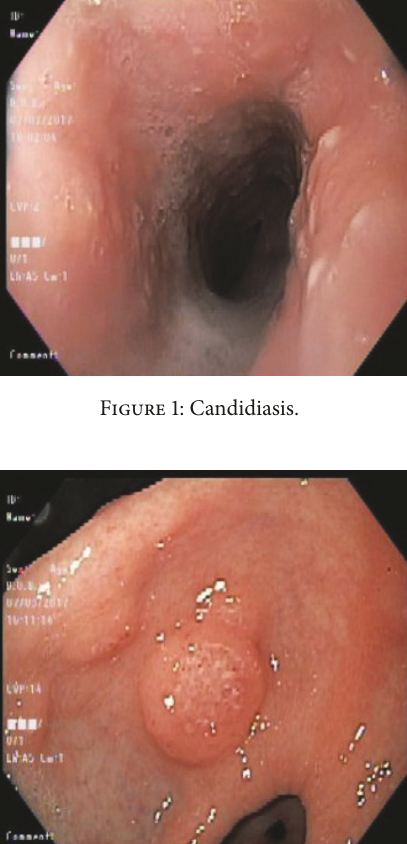
Figure 2: Ulcerated nodule in antrum.